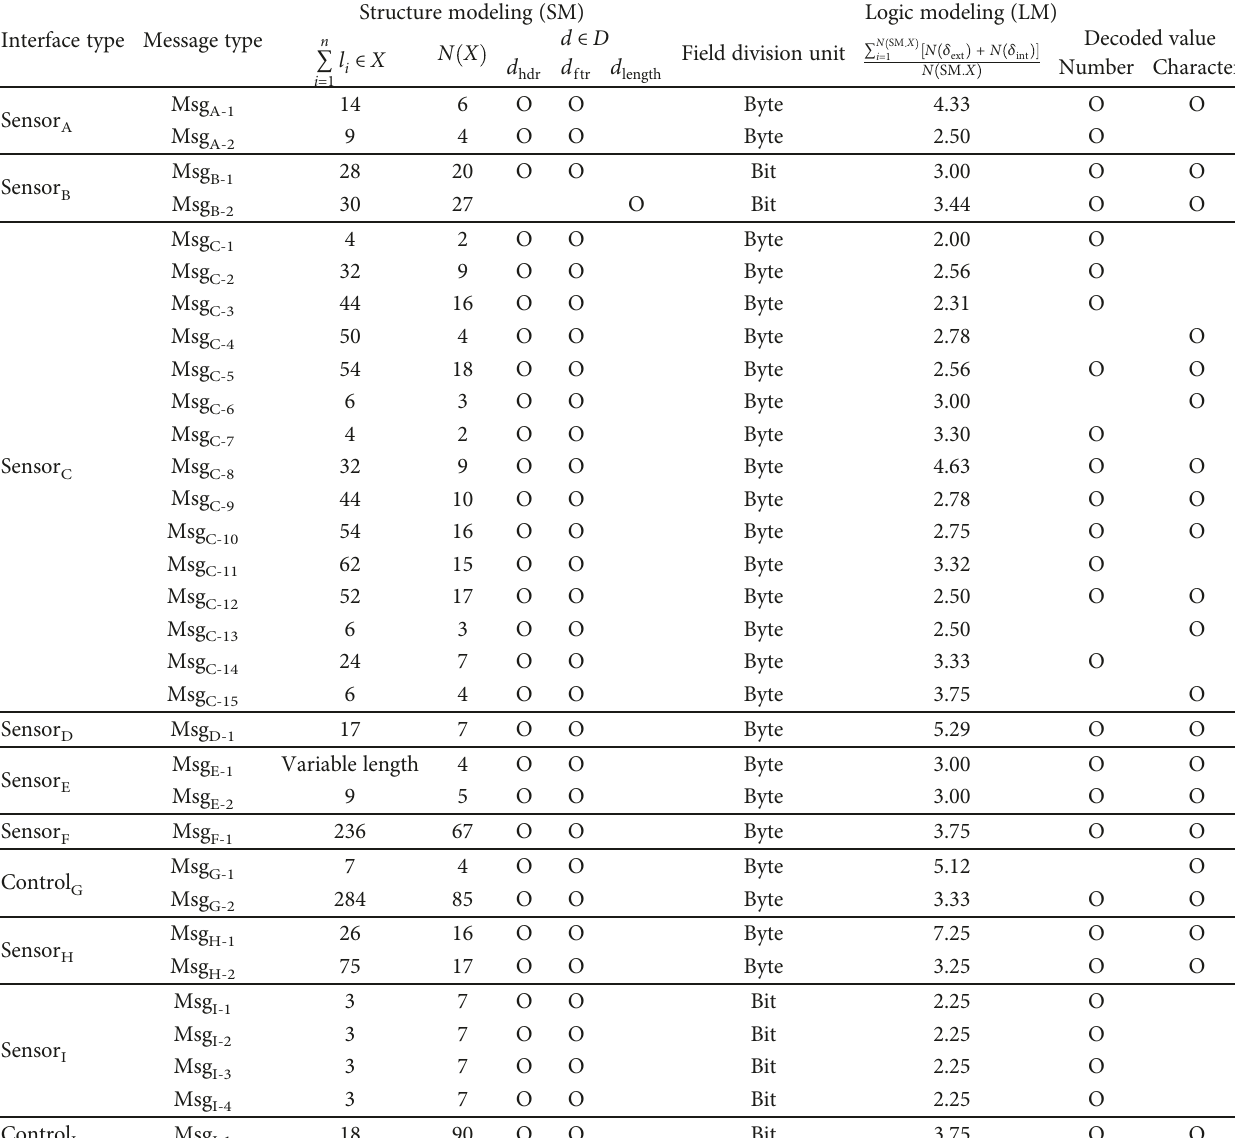
Table 6: Main results of interface data